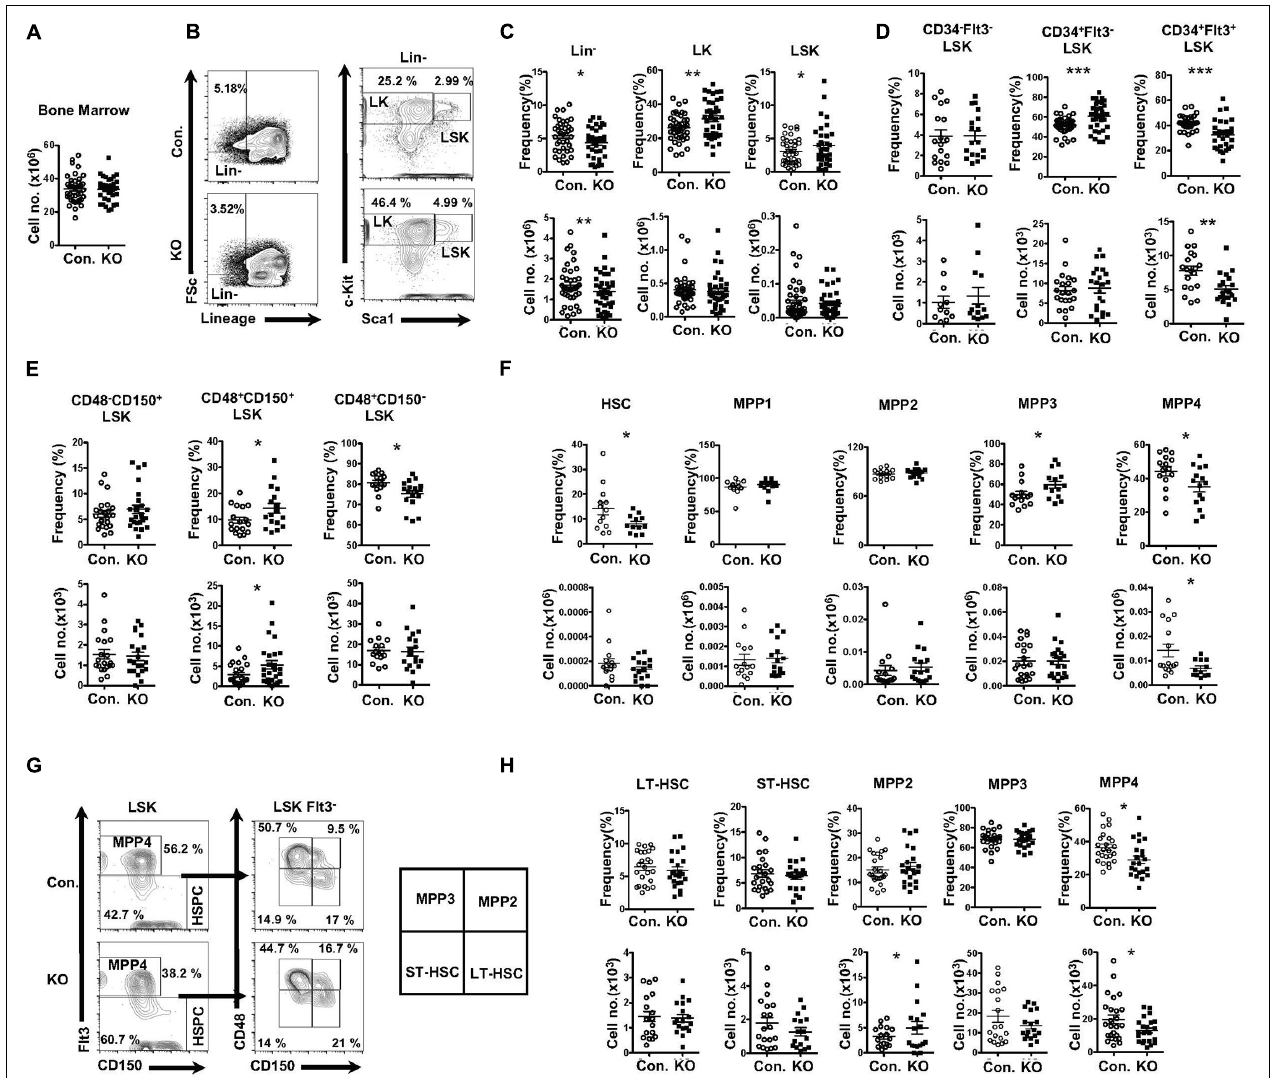
FIGURE 1 | Deficiency of Rbpj affects lymphoid- and erythroid- biased progenitors. (A) Absolute cell number of BM from KO and Control mice ( n = 35–40). (B) FACS plots of Lin − , LK, and LSK subsets of BM (two femurs and two tibias) from KO and control mice. Data are representative of seven independent experiments. (C) Frequencies (top) and absolute numbers (bottom) of Lin-, LK, and LSK subsets of BM (two femurs and two tibias) from KO and control mice ( n = 16–25). (D) Frequencies (top) and absolute numbers (bottom) of LT-HSC, ST-HSC, and MPP subsets of BM (two femurs and two tibias) from KO and control mice ( n = 16–25). (E) Frequencies (top) and absolute numbers (bottom) of CD150 + CD48 − LSK ( LT-HSC), CD150 + CD48 + LSK and CD150 − CD48 + LSK subsets of BM (two femurs and two tibias) from KO and control mice ( n = 16–25). (F) Frequencies (top) and absolute numbers (bottom) of HSC, MPP1, MPP2, MPP3, and MPP4 analysis of BM (two femurs and two tibias) from KO and control mice ( n = 14–20). (G) FACS plots of LT-HSCs, ST-HSCs, MPP2, MPP3, and MPP4 subsets of BM (two femurs and two tibias) from KO and control mice. Data are representative of seven independent experiments. (H) Frequencies (top) and absolute numbers (bottom) of LT-HSCs, ST-HSCs, MPP2, MPP3, and MPP4 subsets of BM (two femurs and two tibias) from KO and control mice ( n = 16–25). All data represent mean ± SEM. Two-tailed Student’s t- tests were used to assess statistical significance (* P < 0.05; ** P < 0.01; *** P < 0.001).